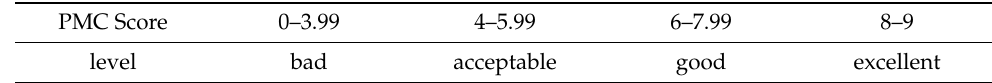
Table 5. Pig price control policy rating table.